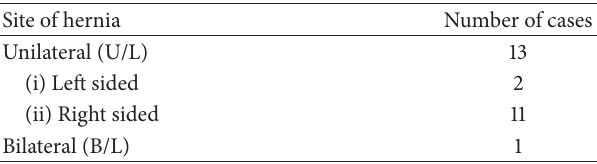
Table 1: Site of lumbar hernia.